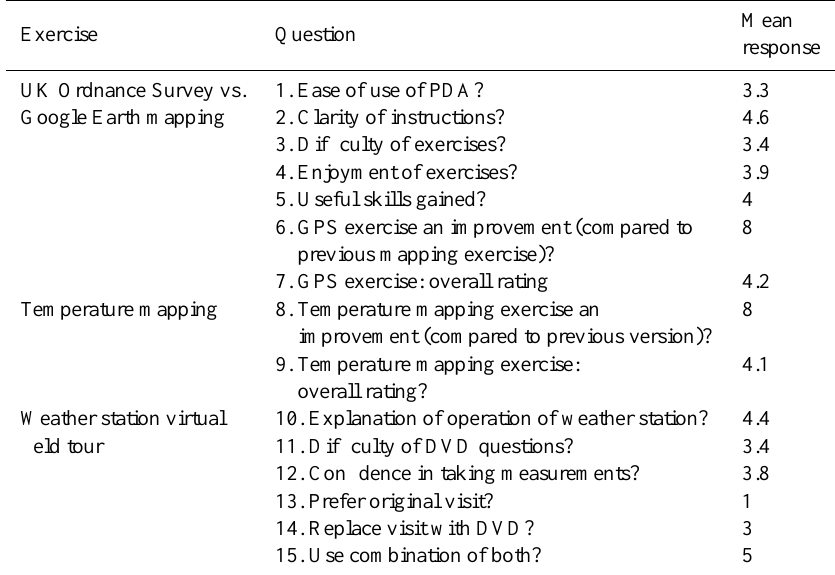
Fig. 2. (a) Start screen for the interactive DVD, (b) example formative multiple choice question from the DVD. Table 1. Responses to questions from the nine focus group participants. Questions 1–5, 7, 9–12 were answered on a likert scale, with 1 indicating a difficult/negative response and 5 easy/positive response. The score for questions 6, 8 and 13 refers to the number of participants (out of 9) who agreed with the